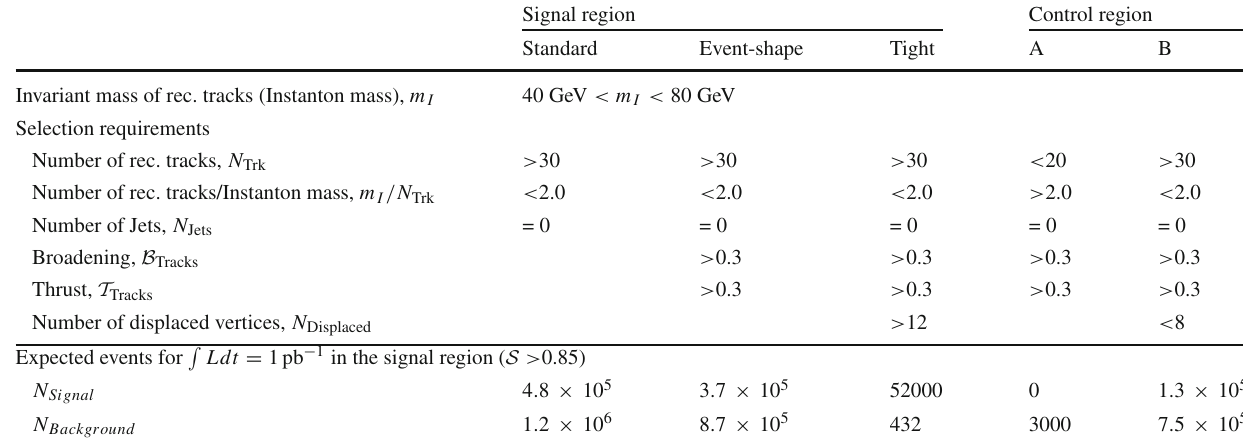
Table 4 Overview of the standard and tight signal selection as well as the definition of two control regions aiming at very low Instanton masses (40 GeV < m I < 80